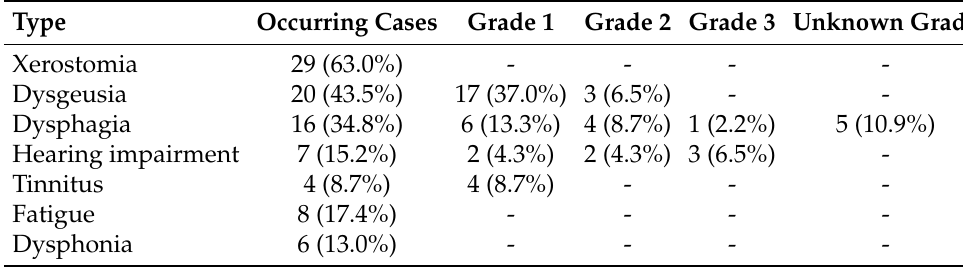
Table 4. Late side effects of radiotherapy, classified by type and grade.